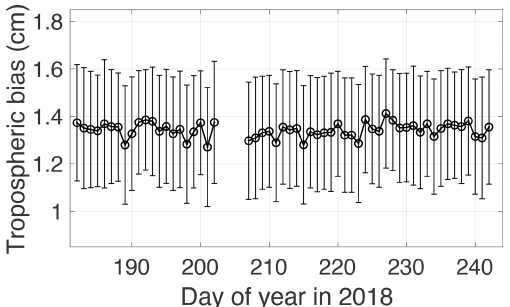
Figure 10. Tropospheric biases of ground surface elevation changes during DOY 182–243 in 2018. They are the mean values of the bi- ases of all satellite tracks, whose standard deviations are represented by error